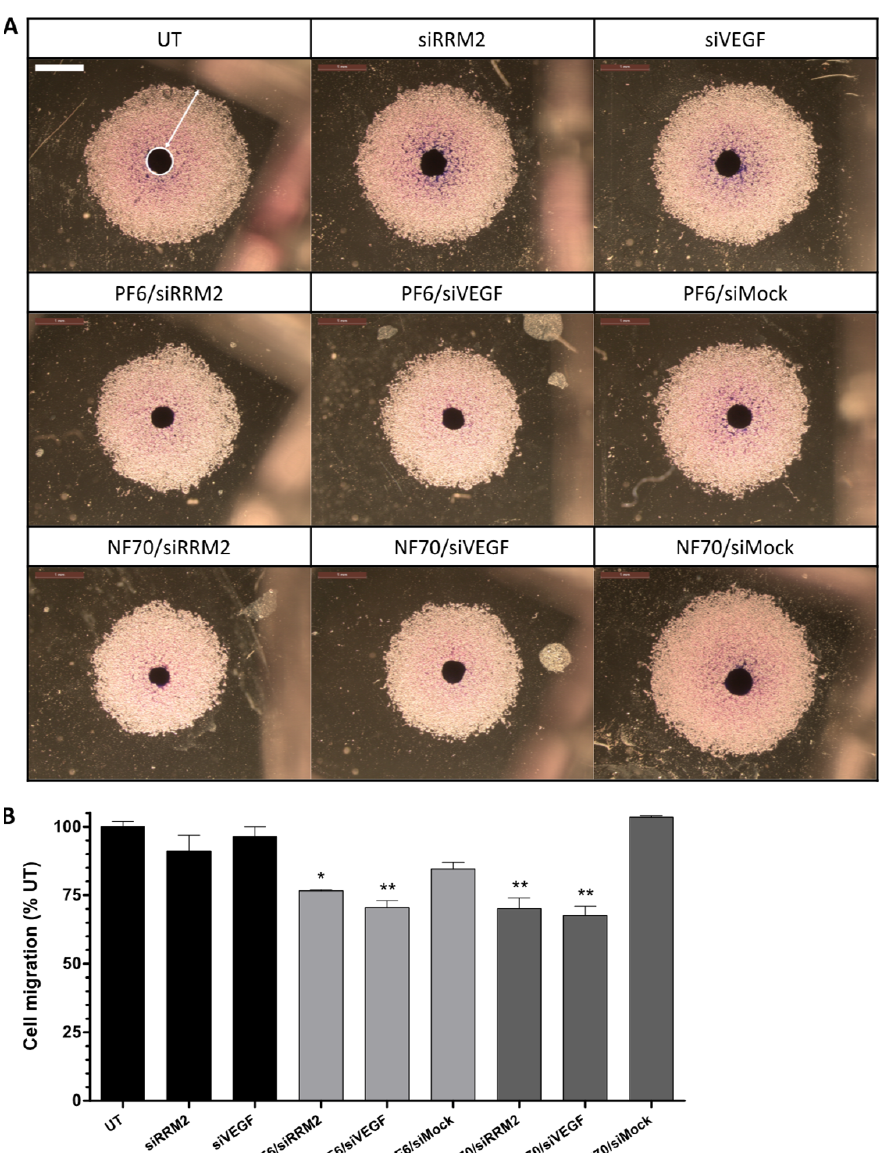
Figure 5. Tumor cell migration from 3D spheroids reduced after therapeutic gene knockdown. ( A ) Representative microscopic images of human fibrosarcoma HT1080 spheroids (white circle) transferred on gelatin-coated plates 48 h after transfection and the surrounding migrating cells (white arrow) 72 h after the transfer. Scale bar: 1 mm. ( B ) Surface area covered by the migrated tumor cells calculated using ImageJ software and normalized to UT group. Error bars represent SEM. * p < 0.05, ** p < 0.01, one-way ANOVA, Tukey post hoc. Results represent 3 individual experiments. UT,